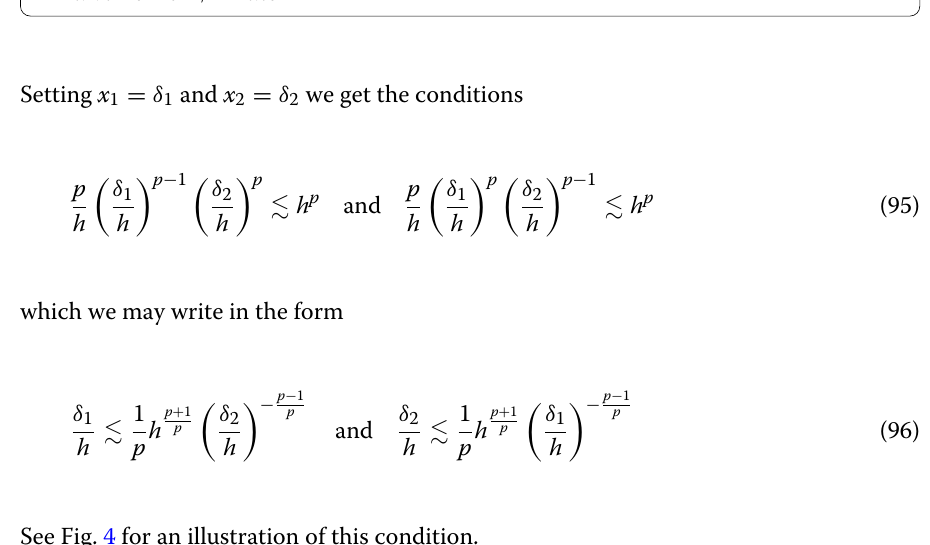
Fig. 4 Illustrations of the basis function intersection condition (51) in energy norm and (96) in max norm for splines of polynomial order p = 1 , 2 , ... , 5. a Energy norm, h = 0 . 1. b Energy norm, h = 0 . 05. c Max norm, h = 0 . 1. d Max norm, h = 0 .